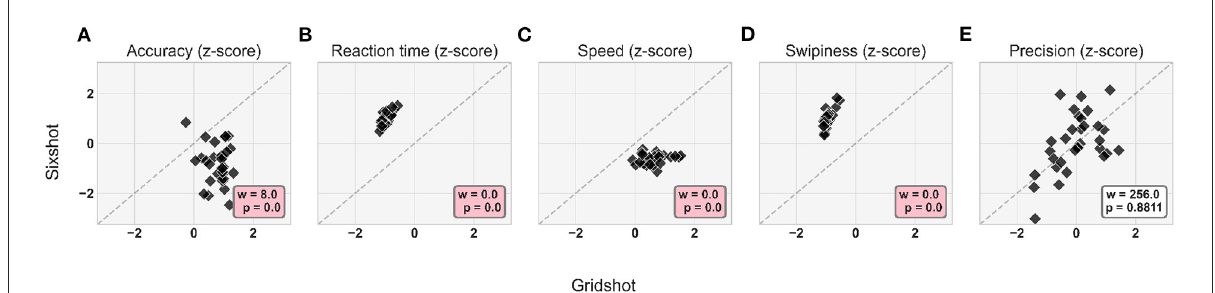
FIGURE6 Differences in movement kinematics for Sixshot vs. Gridshot: (A) Accuracy. (B) Reaction time. (C) Speed. (D) Swipiness. (E) Precision. Each data point within each panel corresponds to a different player. Statistical results from the paired Wilcoxon signed-rank test displayed in annotation boxes; where w is sum of ranks, and p is p -value. Pink annotation boxes indicate a p < 0.05. The dashed diagonal represents the values at which the kinematic z-scores for Gridshot is equal to